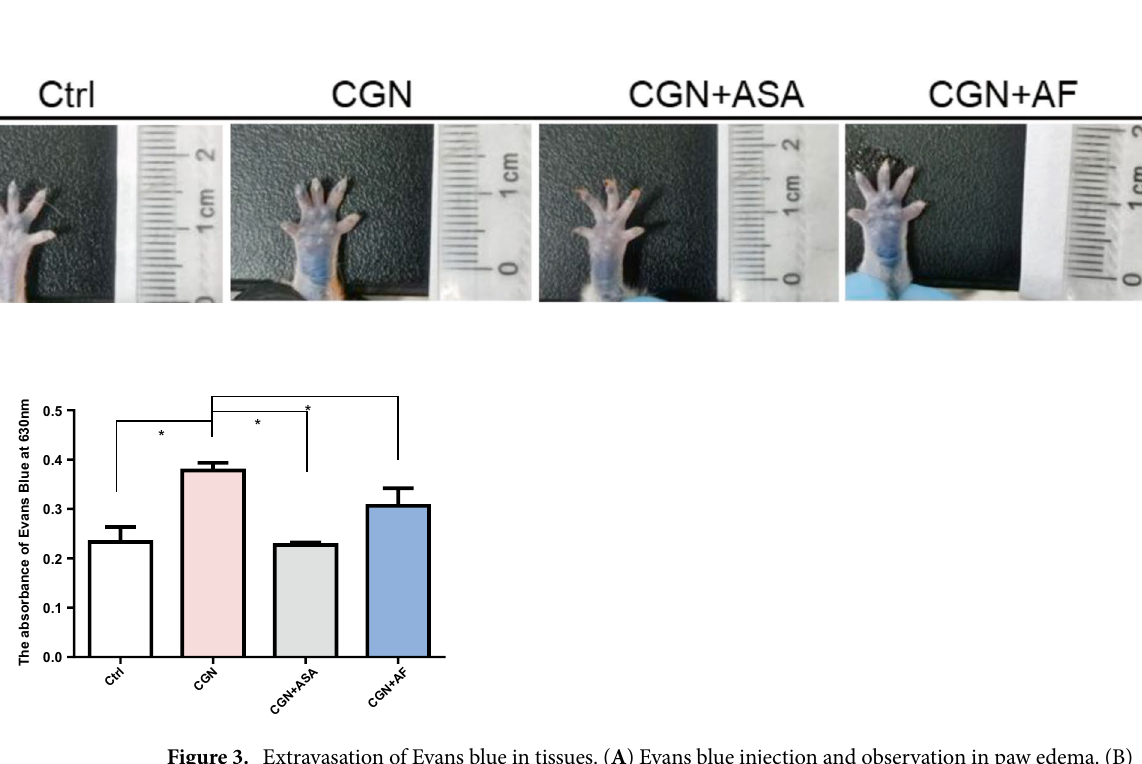
Figure 3. Extravasation of Evans blue in tissues. ( A ) Evans blue injection and observation in paw edema. (B) The Evans blue level in the paw edema tissue was collected and the level was determined by its absorption at the wavelength of 630 nm by using a microplate reader. Numerical data are presented as mean ± SEM (n = 5). * P < 0.05 were considered as significant difference compared to the control